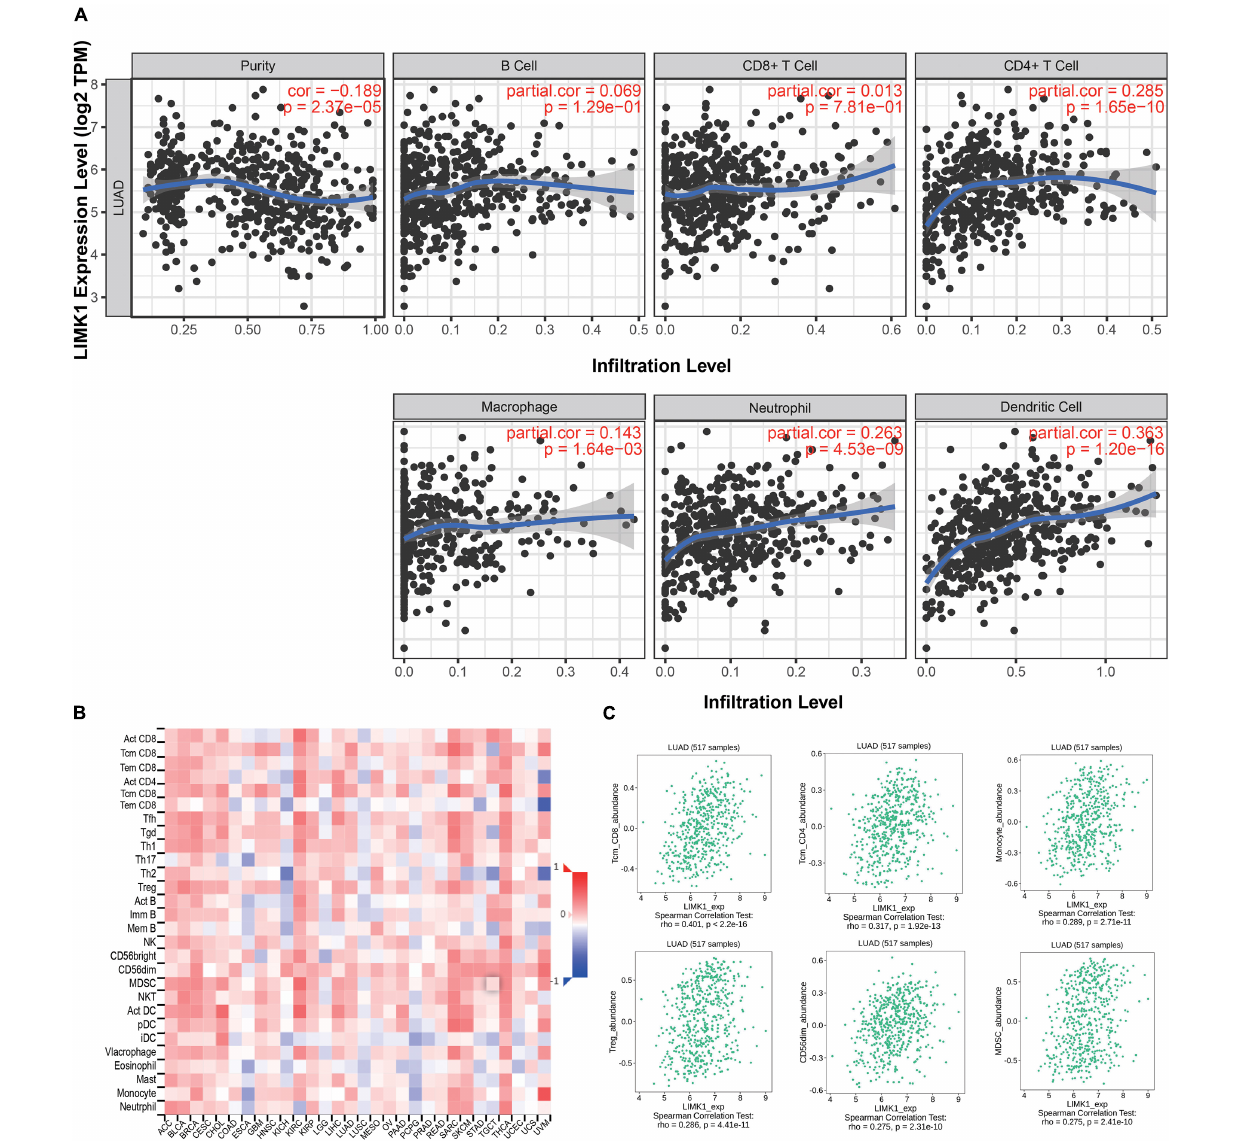
FIGURE 6 | Correlations of LIMK1 expression with immune infiltration level. (A) LIMK1 expression is negatively related to tumor purity and has correlations with dendritic cell, CD4 + T cell, neutrophil, and macrophage in lung adenocarcinoma. (B) Relations between the expression of LIMK1 and 28 types of TILs across human cancers. (C) LIMK1 was correlated with abundance of CD8 + T cells, CD4 + T cells, monocyte cells, Treg cells, CD56dim cells, and MDSC